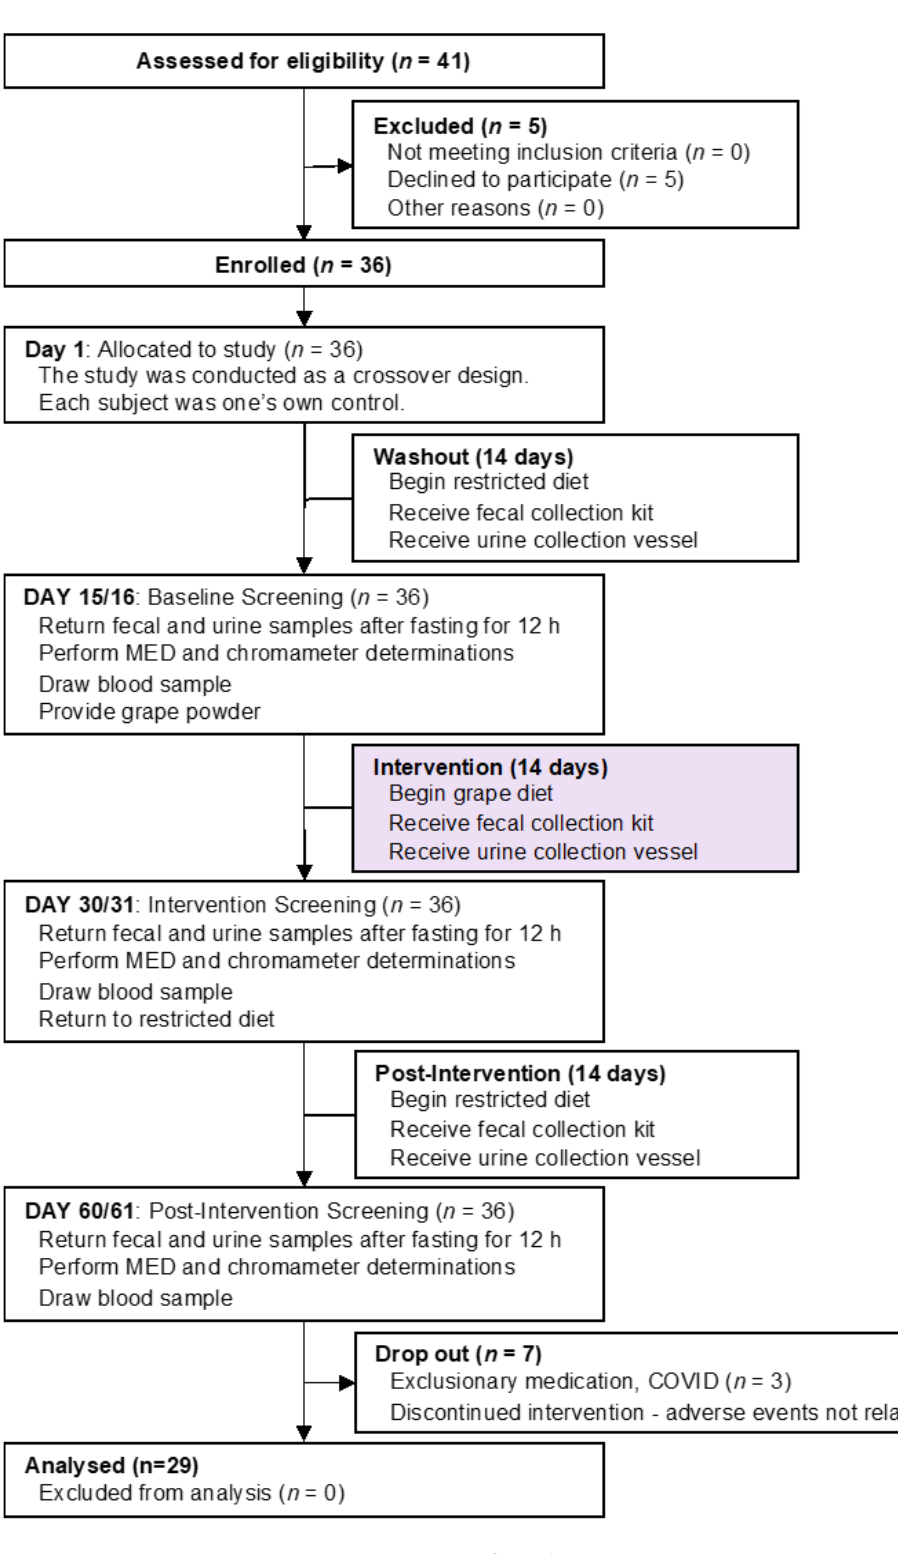
Figure 1. Participant flow chart.